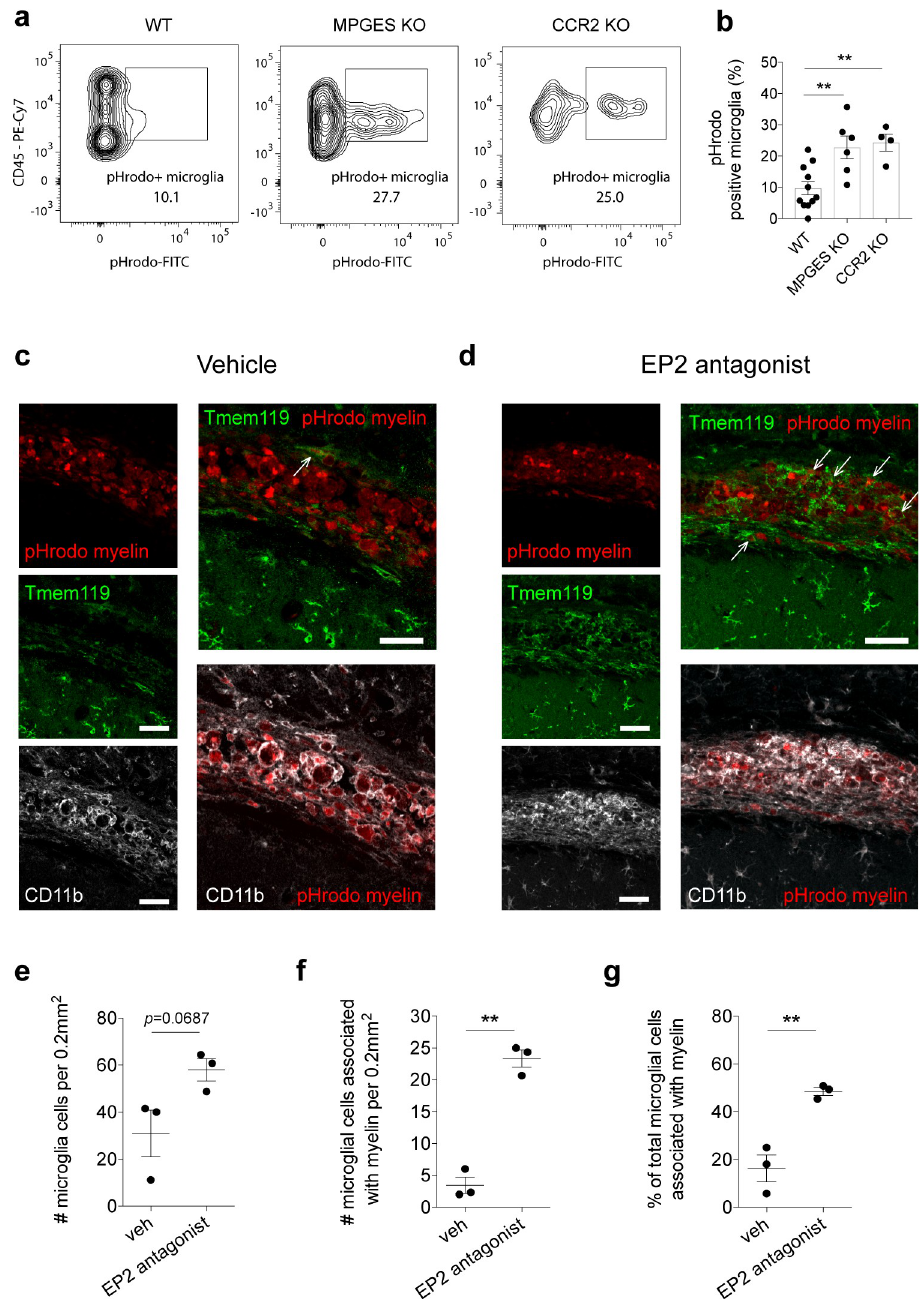
Fig 4. Lack of macrophages and loss of PGE 2 signaling via the EP2 receptor increases microglia phagocytosis in vivo. ( a-b) Myeloid cells were isolated from the injured spinal cord of WT, mpges −/− , and CCR2 KO mice three days after SCI, and immediately treated with pHrodo (green)-labeled myelin for four hours. MDM and neutrophil populations were excluded by gating CD11b + /CD45 + /Ly6G − ve /Ly6C − ve cells. ( a ) Representative FACS plots show proportions of microglia positive for pHrodo (Green)-myelin. ( b ) Graph shows significantly increased phagocytosis by microglia after SCI in mpges −/− and CCR2 KO mice compared with WT control. ( c-g ) In vivo injection into the corpus callosum of pHrodo-labeled myelin in conjunction with vehicle (control) or EP2 receptor antagonist (PF-0441894; 1 μ M) in WT mice. Association of microglia (Tmem119; green) with pHrodo-myelin (red) was assessed at the site of injection in the two groups, vehicle ( c ) and EP2 receptor antagonist ( d ). In the EP2 antagonist–treated group, there is an increase in the number of microglia at the injection site ( e ), the number of microglia that contact or contain pHrodo-myelin ( f ), and the percentage of total microglia that are in contact or contain pHrodo-myelin ( g ),